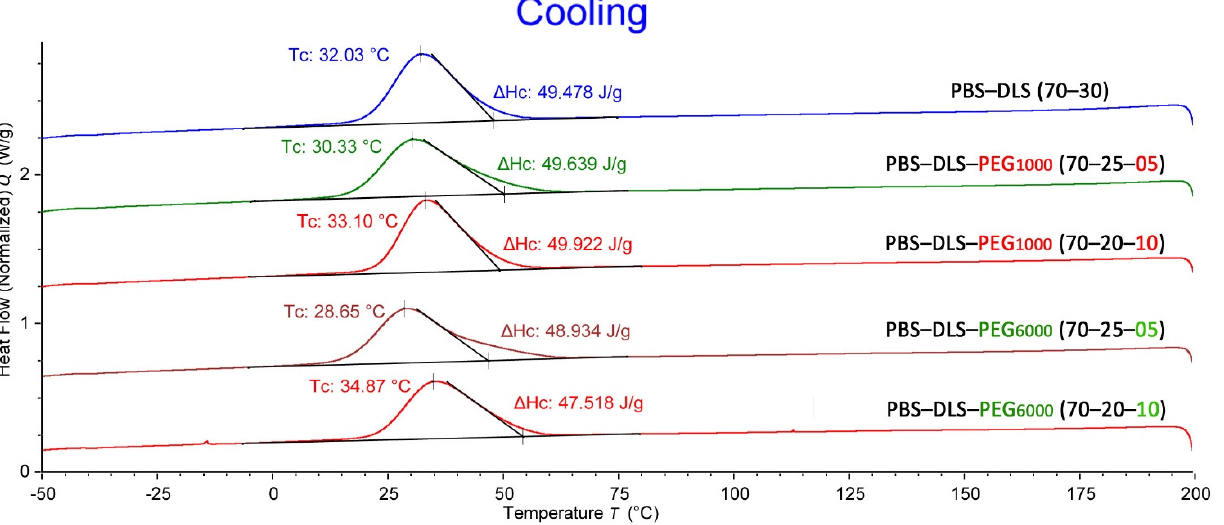
Figure 7. The DSC cooling thermograms for PBS-DLS, PBS-DLS-PEG 1000 and PBS-DLS-PEG 6000 of different segmental com- positions. Table 5. Summary of DSC analysis of newly synthesized PBS-DLS-PEG copolymers with two dif- ferent molecular weights of PEG 1000 and PEG 6000 .